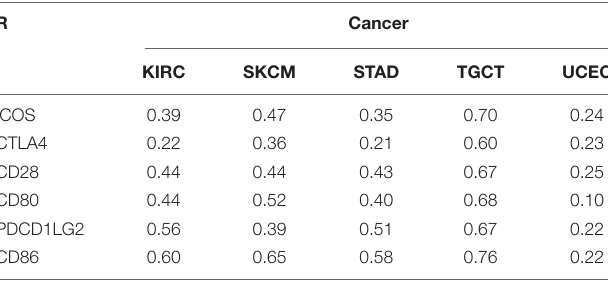
TABLE 1 | The relationship between TLR4 gene expression in KIRC, SKCM, STAD, TGCT, UCEC and immune checkpoint. R Cancer KIRC SKCM STAD